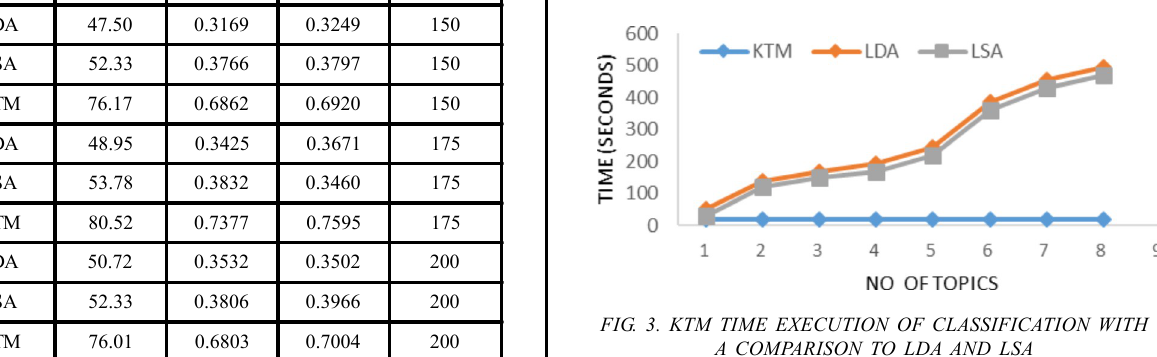
FIG. 3. KTM TIME EXECUTION OF CLASSIFICATION WITH A COMPARISON TO LDA AND